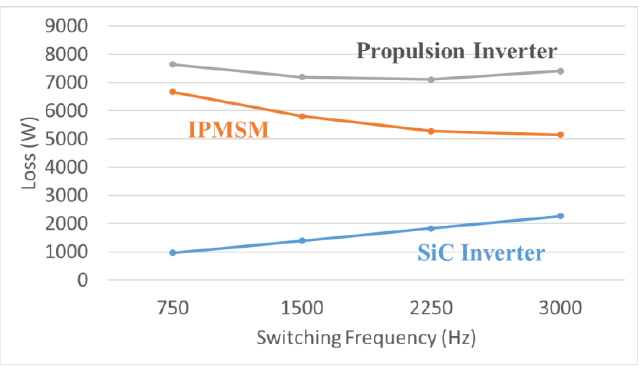
Figure 15. The power loss analysis result of the propulsion system as 1200 r/m.